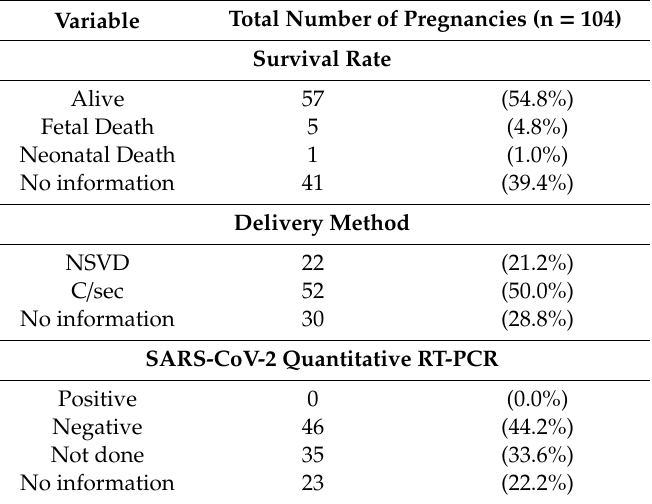
Table 8. Characteristics of fetal and neonatal outcomes from COVID-19 pregnancies.